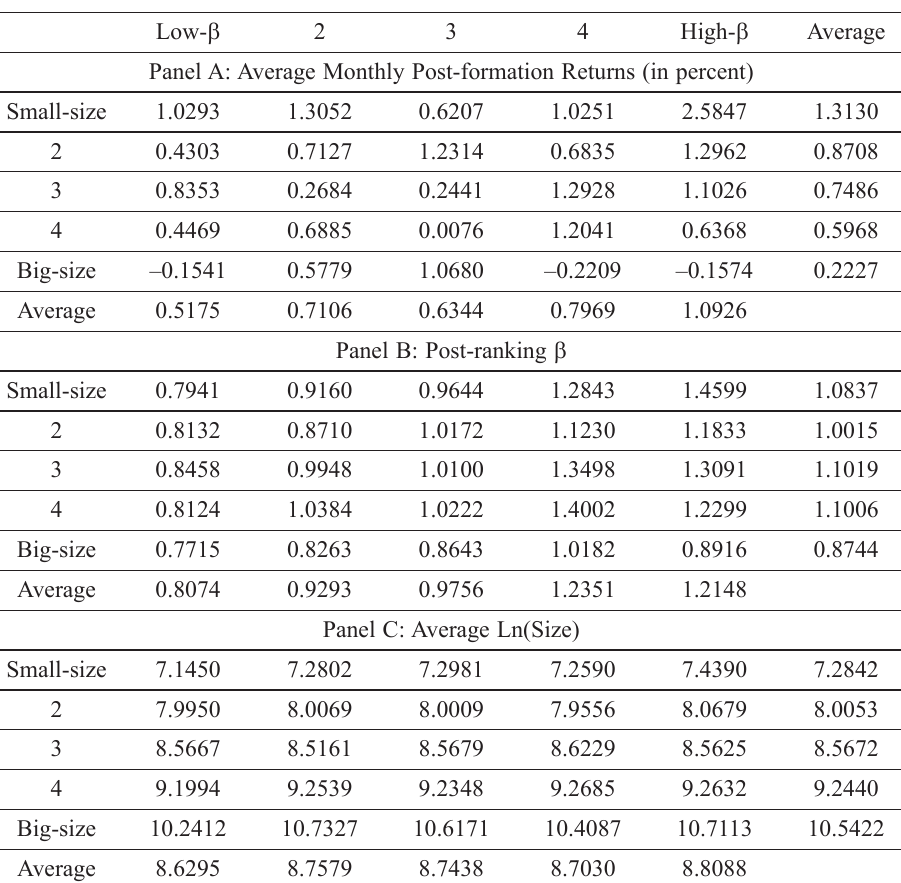
Table 4. Properties of portfolios formed on size and pre-ranking β : stocks sorted by size (down) then pre-ranking β (across),